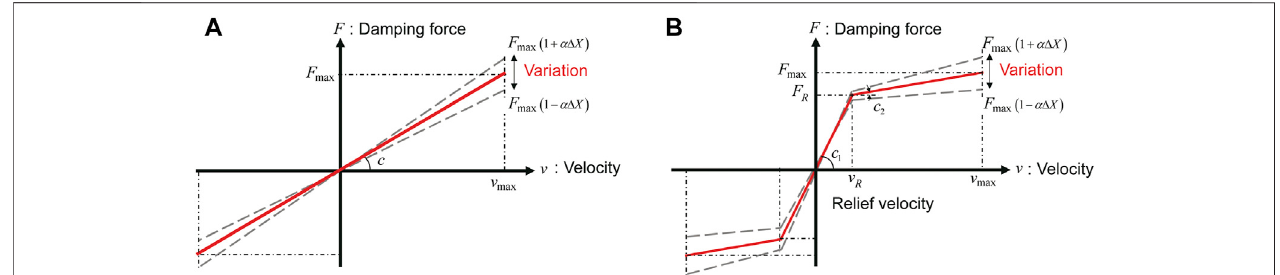
FIGURE 4 | Uncertainty in maximum damping force of oil dampers, (A) Linear oil damper, (B) Bi-linear oil damper.